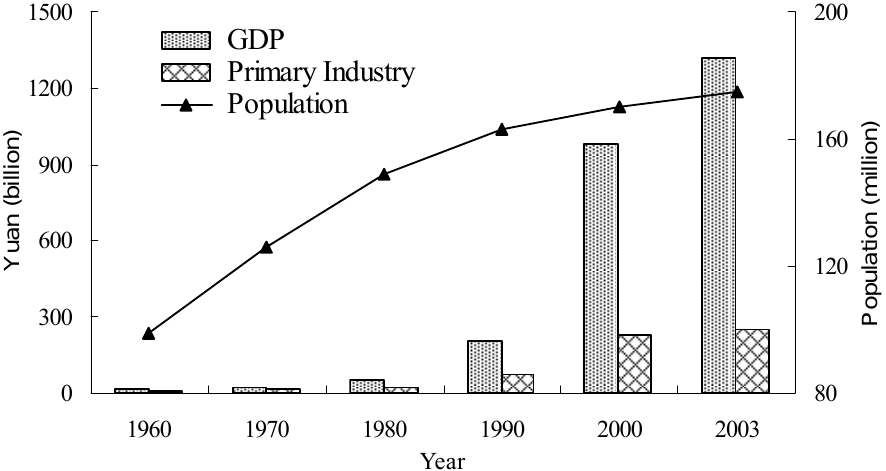
Figure 5. GDP and population changes in the upper reaches of the Yangtze River during